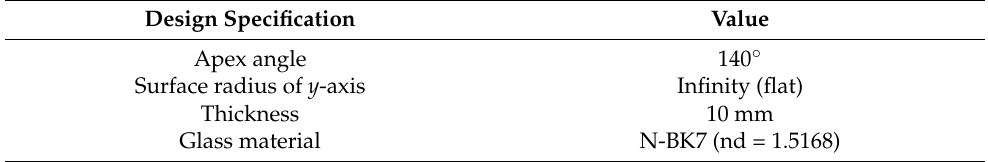
Table 2. Specifications of designed